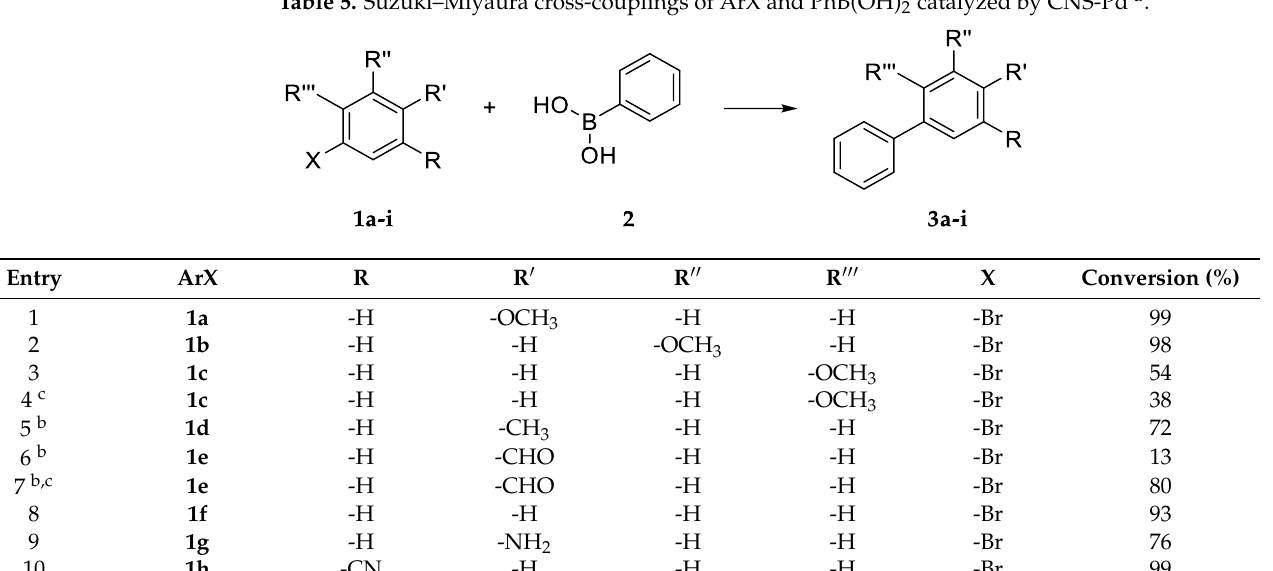
Gels 2022 , 8 , x FOR PEER REVIEW